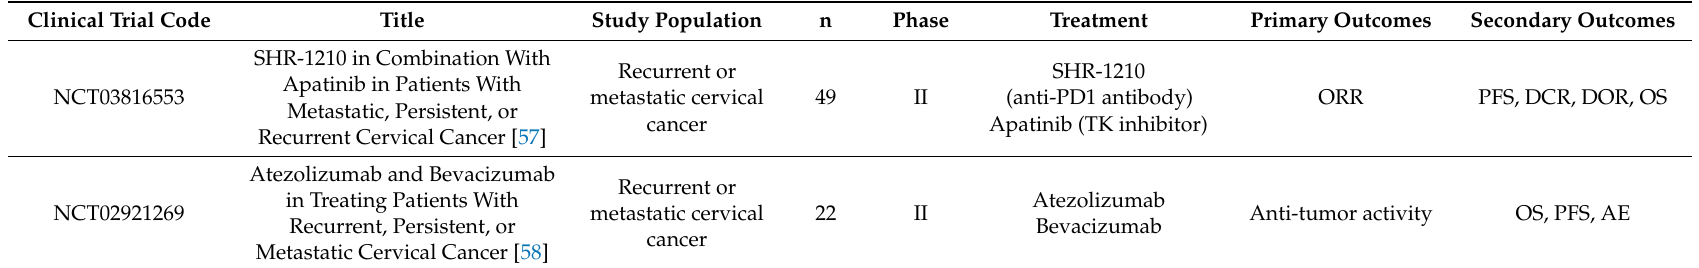
Table 6. Ongoing clinical trials of immunotherapy for cervical cancer (combinations with molecularly-targeted therapy). Clinical Trial